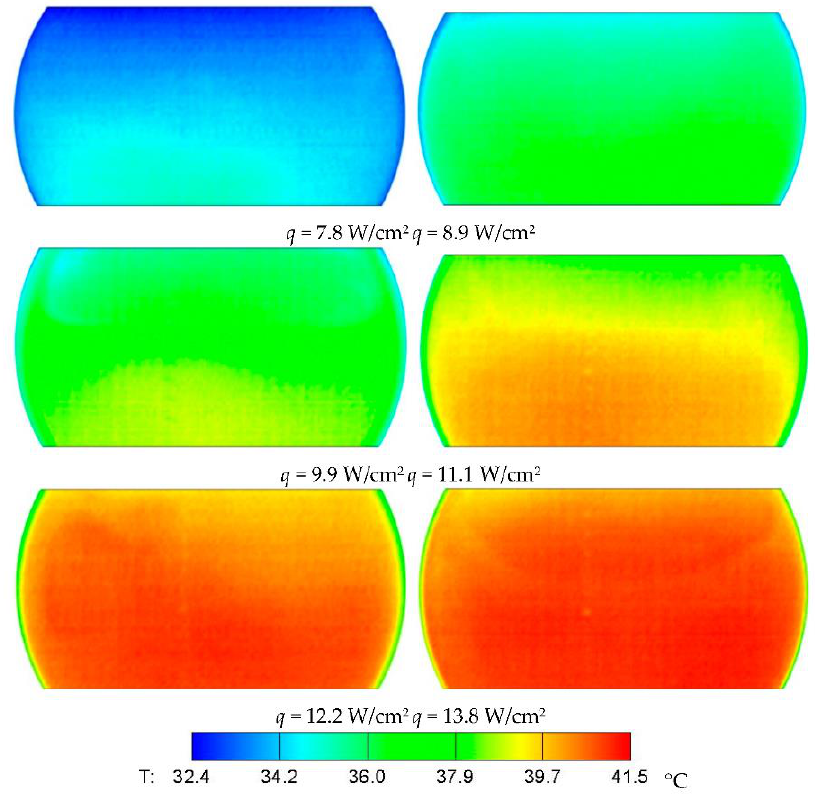
Figure 9. Infrared thermal images of the vapor chamber under different heat inputs ( φ = 50%, H = 20